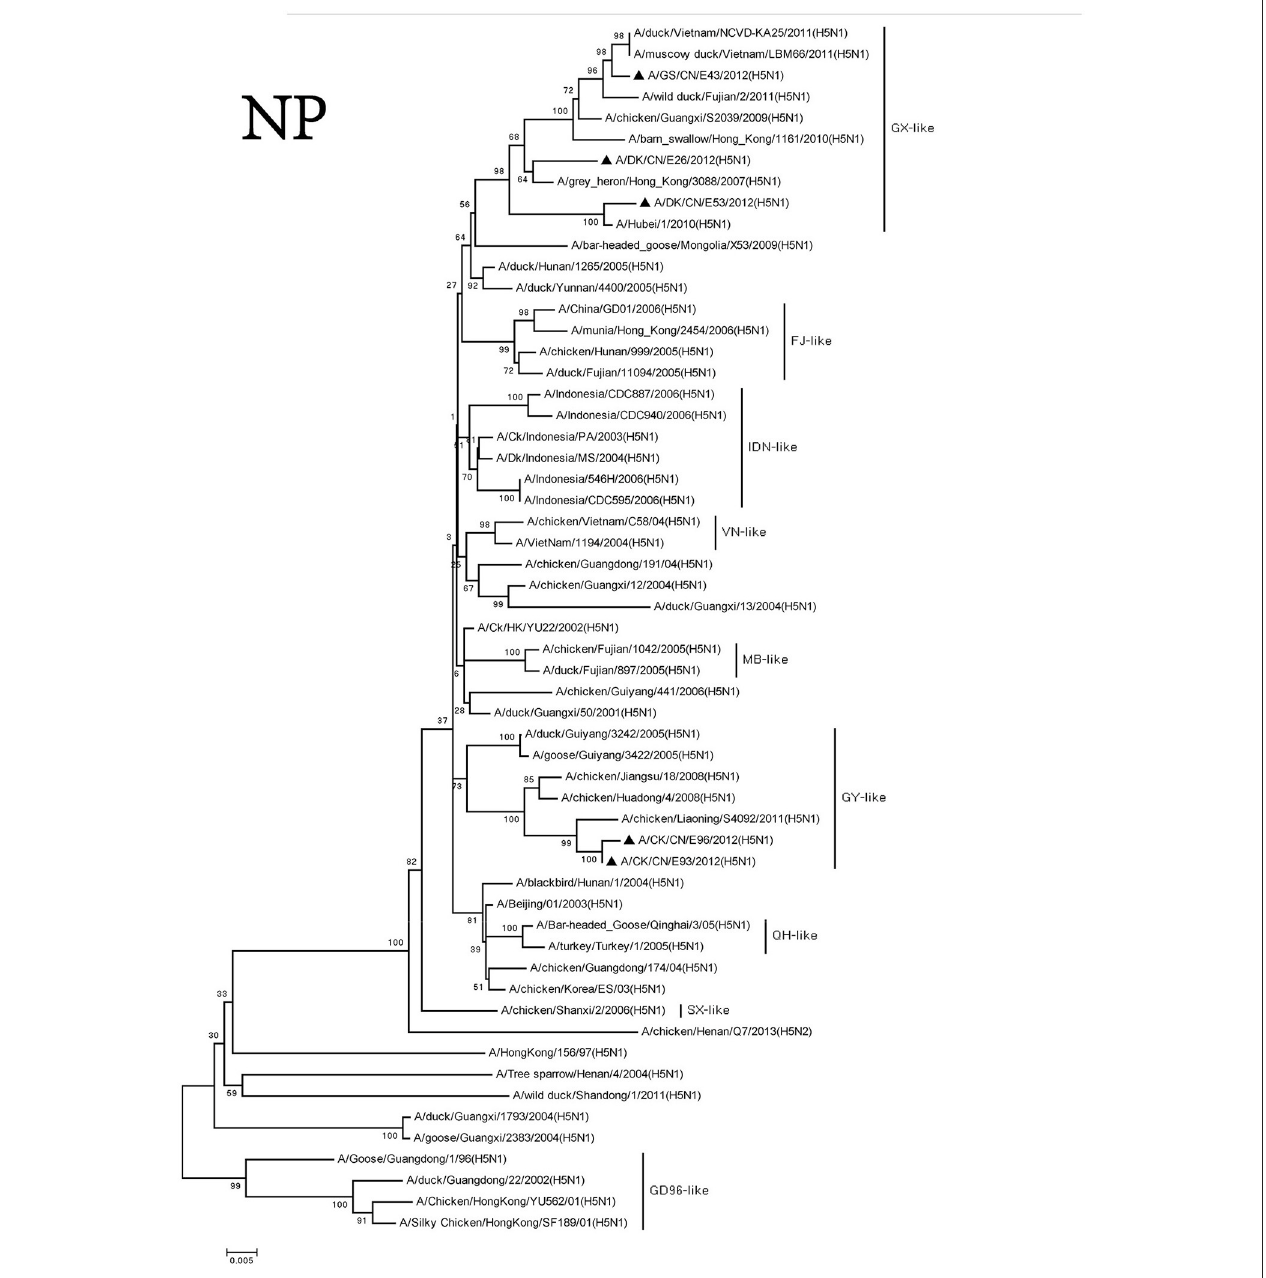
FIGURE 6 | Phylogenetic analysis of NP. NP: nt46–1,542. Except our isolate, other virus sequences were downloaded from GenBank. QH, Qinghai; VN, Vietnam; IDN, Indonesia; GY, Guiyang; MG, Mongolia; GX, Guangxi; HD, Huadong; SX, Shanxi.